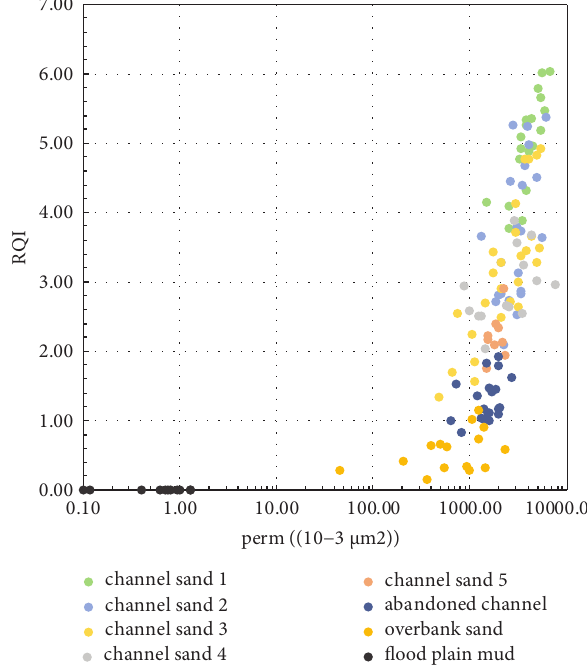
Figure 5: RQI distribution of different microfacies